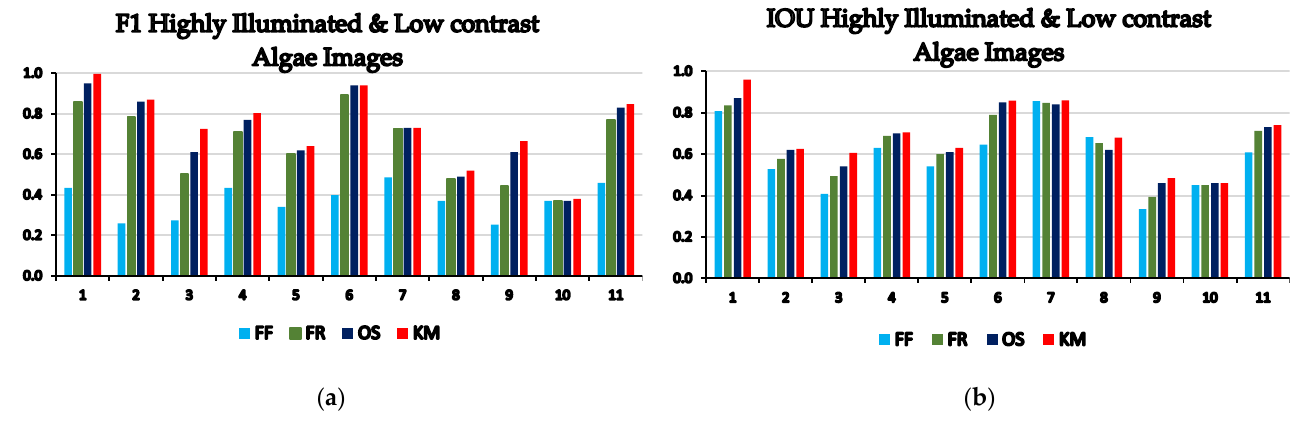
Figure 3. The results of evaluating the tested segmentation algorithms using highly illuminated and low contrast algae images. Images (1 – 6) had two categories, and (7 – 11) had three categories: ( a ) F1-score; ( b ) IOU.